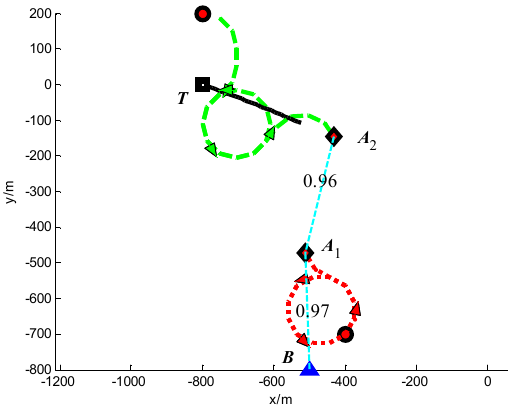
Figure 6. Trajectories of UAVs and target at t = 30 s (Group A in Scenario 1).